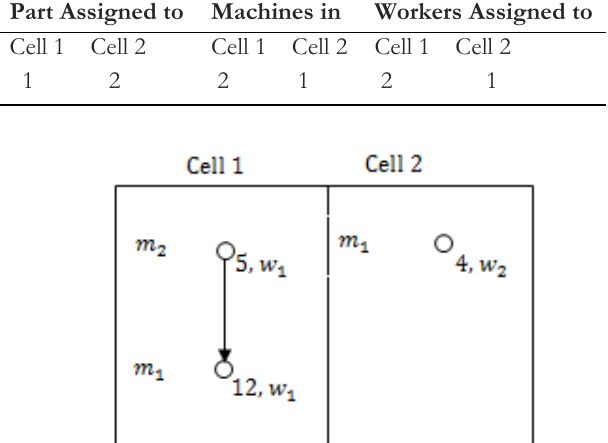
Table 7. Output information of assigning part, machine, and worker to cells.